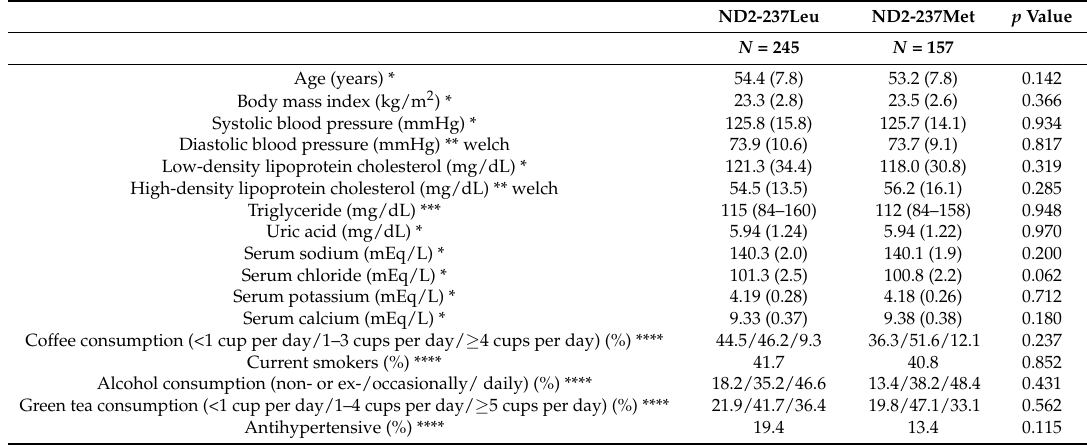
Table 1. Clinical characteristics of the study participants by ND2-237 Leu/Met genotype.